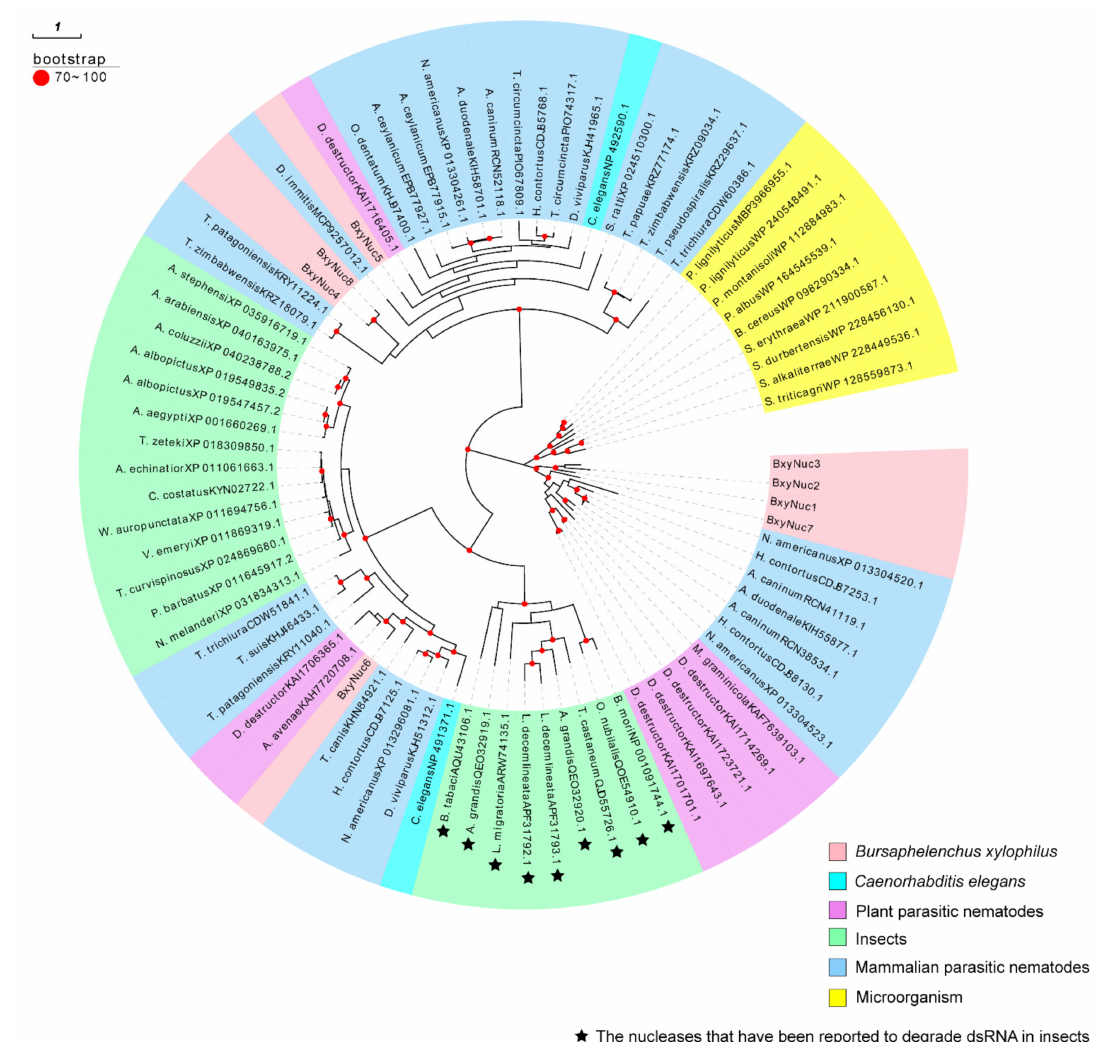
Figure 4. A phylogenetic tree constructed using 75 amino acid sequences from B. xylophilus, C. elegans , plant-parasitic nematodes, insects, mammalian parasitic nematodes and microorganisms with the maximum likelihood method (1000 bootstrap